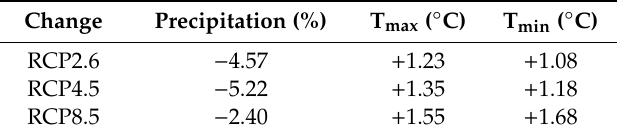
Table 9. Changes of the mean annual precipitation, maximum air temperature (T max ) and minimum air temperature (T min ) during the 2021–2050 period under the three Representative Concentration Path (RPC) scenarios in the Heihe River Basin compared with the baseline period (1976–2005). Change Precipitation (%) T max ( ◦ C) T min ( ◦ C)